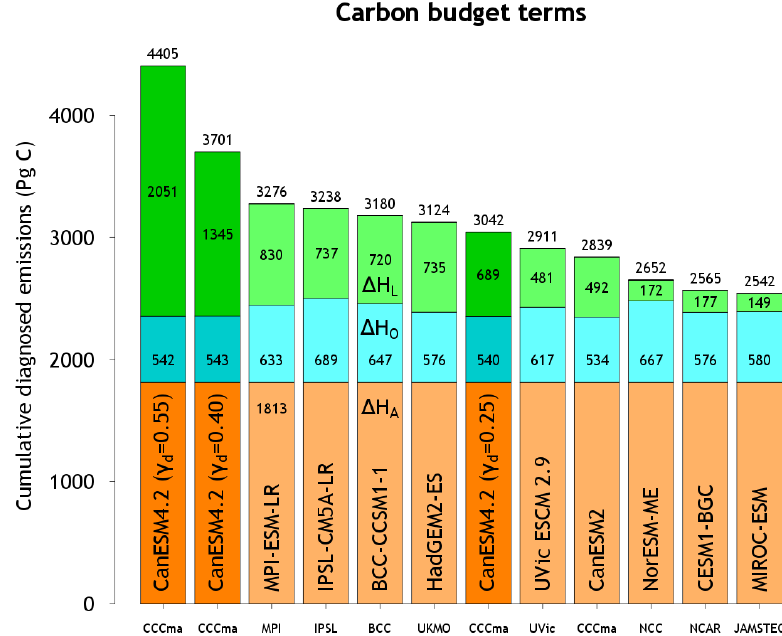
Figure 2. Components of the carbon budget Eq. (8) that make up cumulative diagnosed emissions based on results from the fully cou- pled 1pctCO2 experiment. Results shown are from eight CMIP5 models that participated in the Arora et al. (2013) study and from three CanESM4.2 simulations (shown in darker colours) for three different strengths of the terrestrial CO 2 fertilization effect.